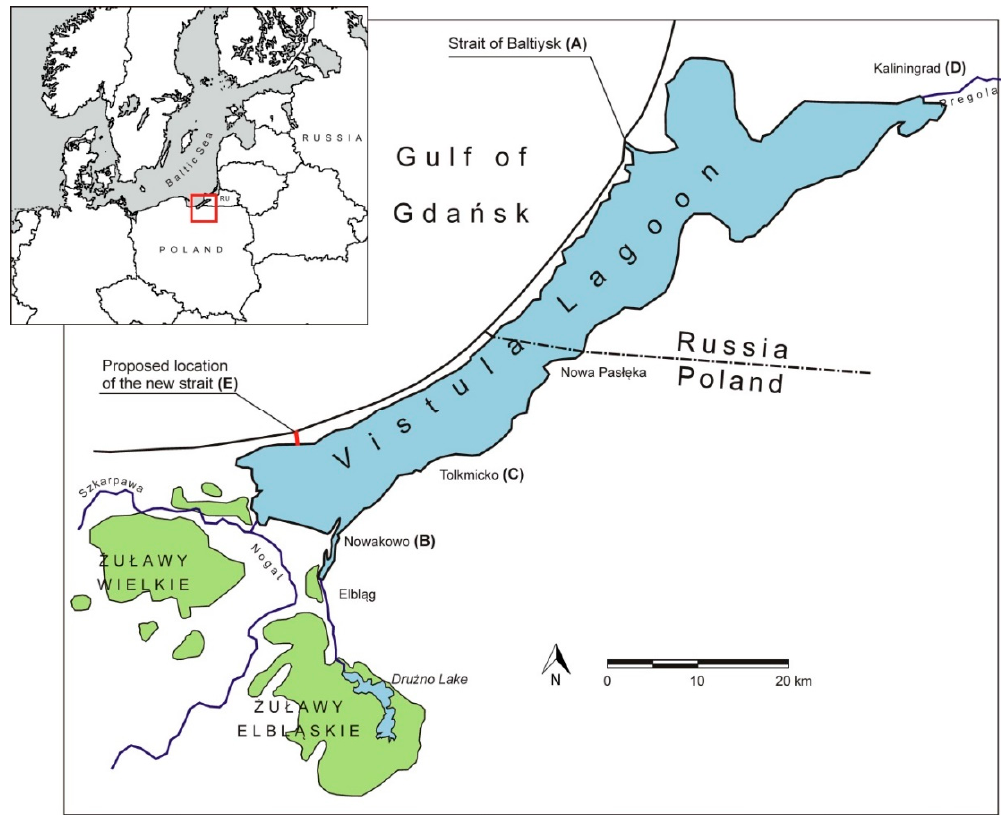
Figure 1. Location of the Vistula Lagoon.